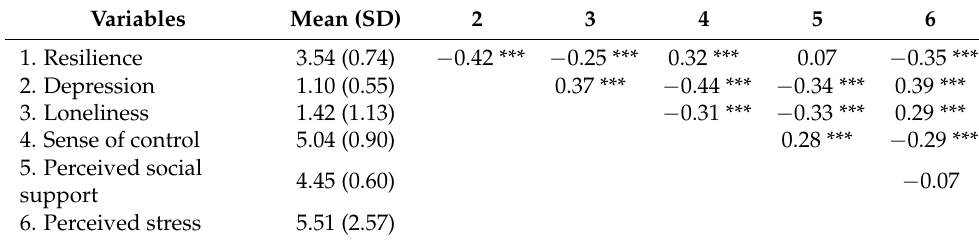
Table 1. Correlates, means, SDs, and ranges of study variables ( n =